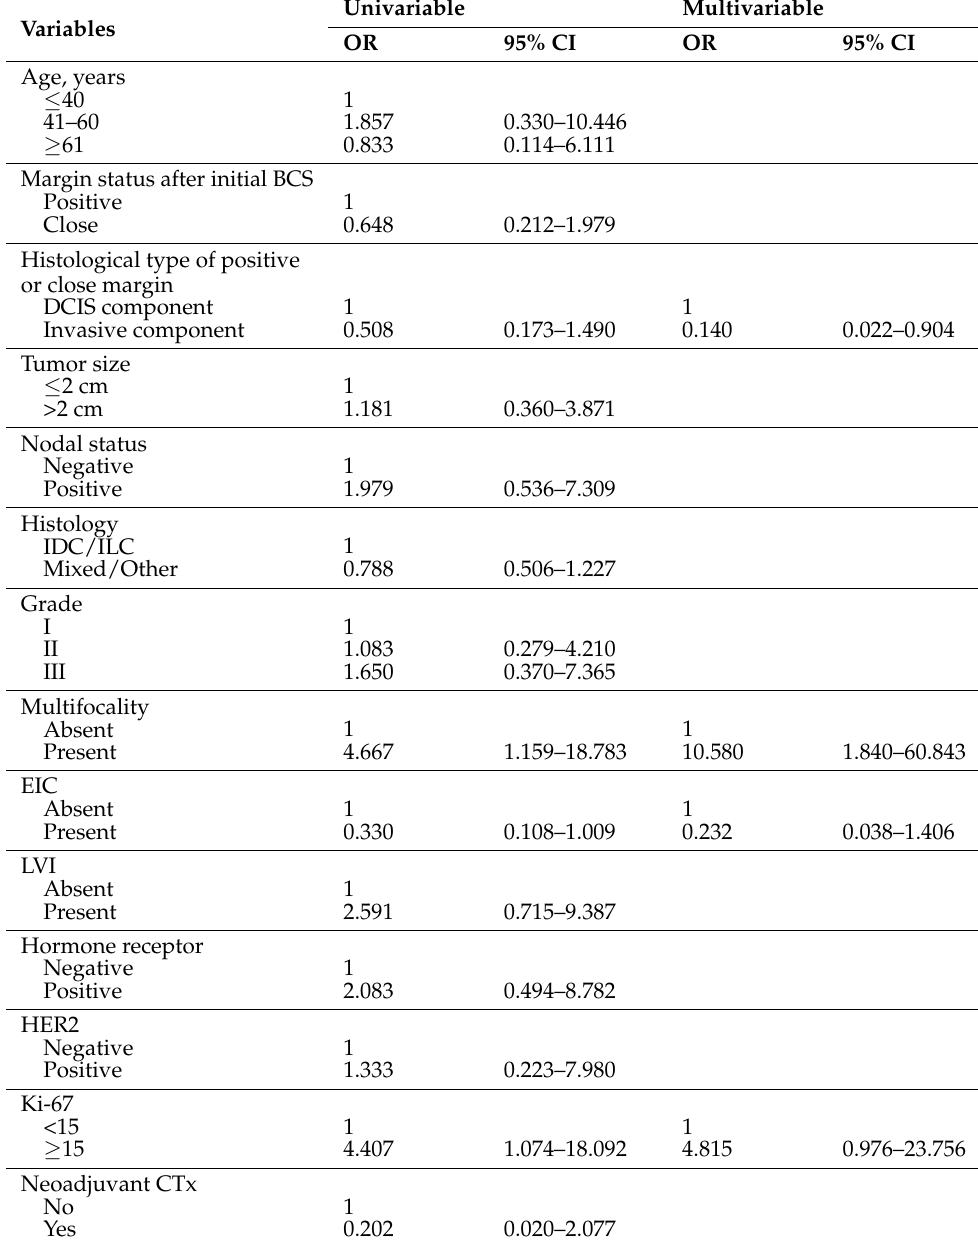
Table 4. Logistic regression analysis of predictive factors associated with residual disease in patients who underwent